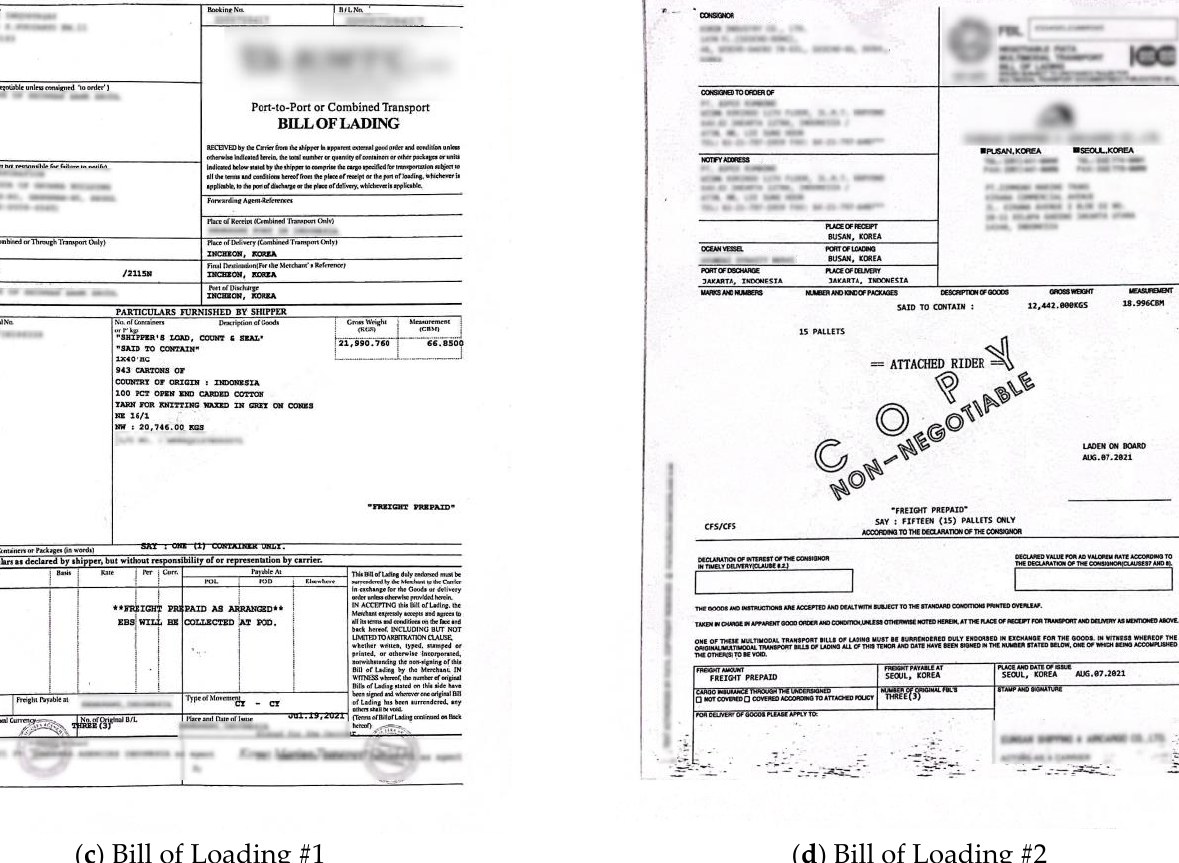
Figure 1. Examples of unstructured financial documents.